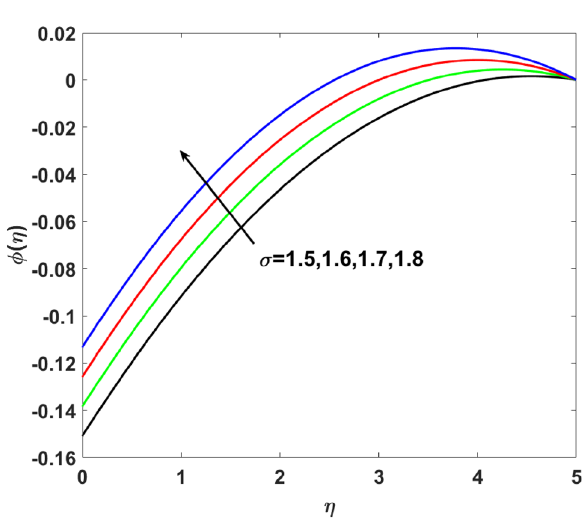
Figure 15. φ(η) versus σ